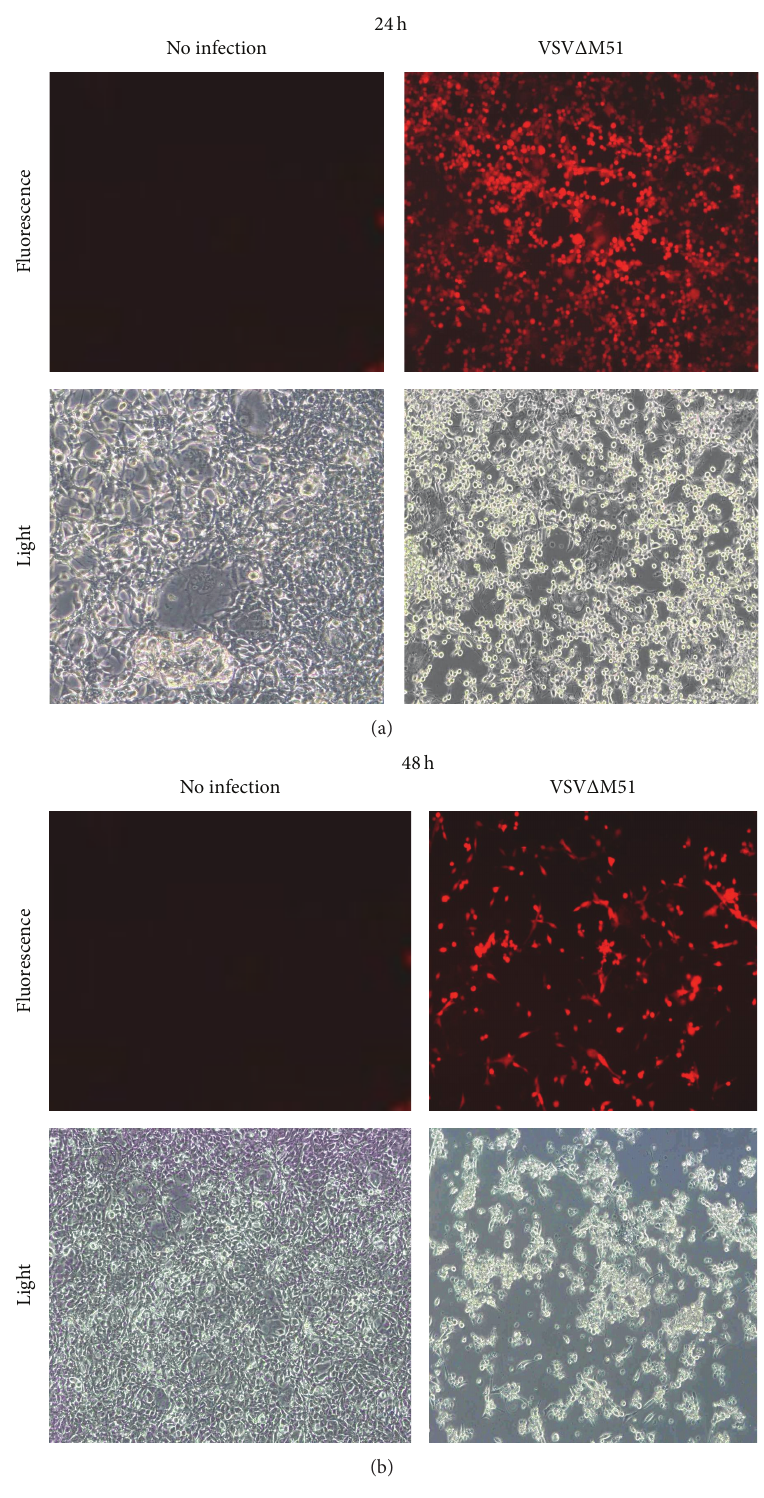
Figure 3: VSV Δ M51 infects and kills EWS cells established from the patient’s tumor specimen. EWS cells were inoculated with VSV Δ M51- RFP at MOI 0.01. Viral replication was assessed at 24 h and 48h by fluorescent microscopy for RFP expression. Light microscopy was used to assess cell death after infection. Robust infection was noted at 24 h and massive cell death was confirmed qualitatively by characteristic cytopathic rounding and detachment of cells off the culture dish at 48